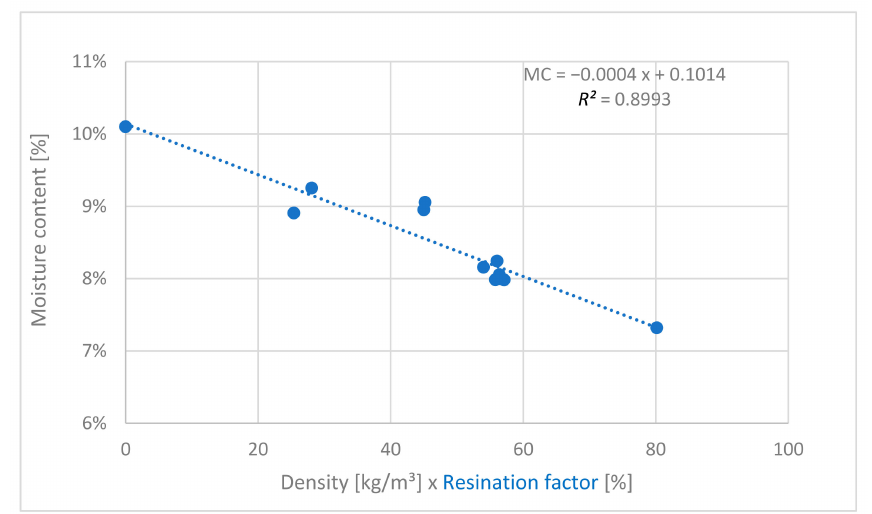
Figure 1. Correlation between moisture content (MC) vs. density and resination factor.